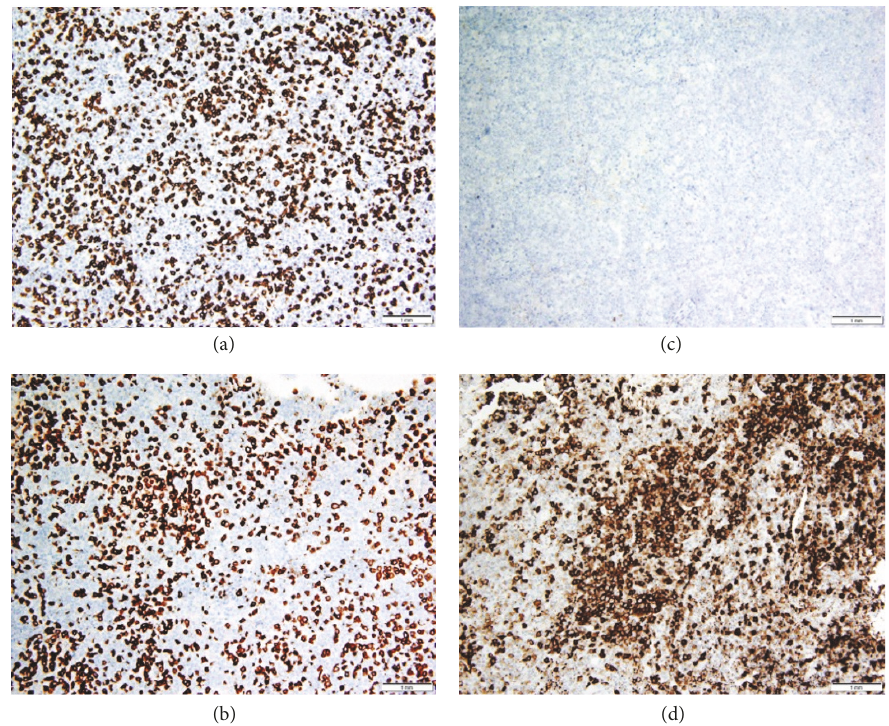
Figure 3: Immunostaining for CD3 (a) and CD5 (b) highlights background small, reactive T-cells. The large, atypical B-cells are negative. The large neoplastic B-cells are negative for CD5 and CD23 (c). CD20 is positive in large, atypical B-cells (d). The background small lymphocytes (reactive T-cells) are negative. The overall immunostaining pattern excludes both EBV+ CLL and EBV+ T-cell lymphoma as possible diagnoses.